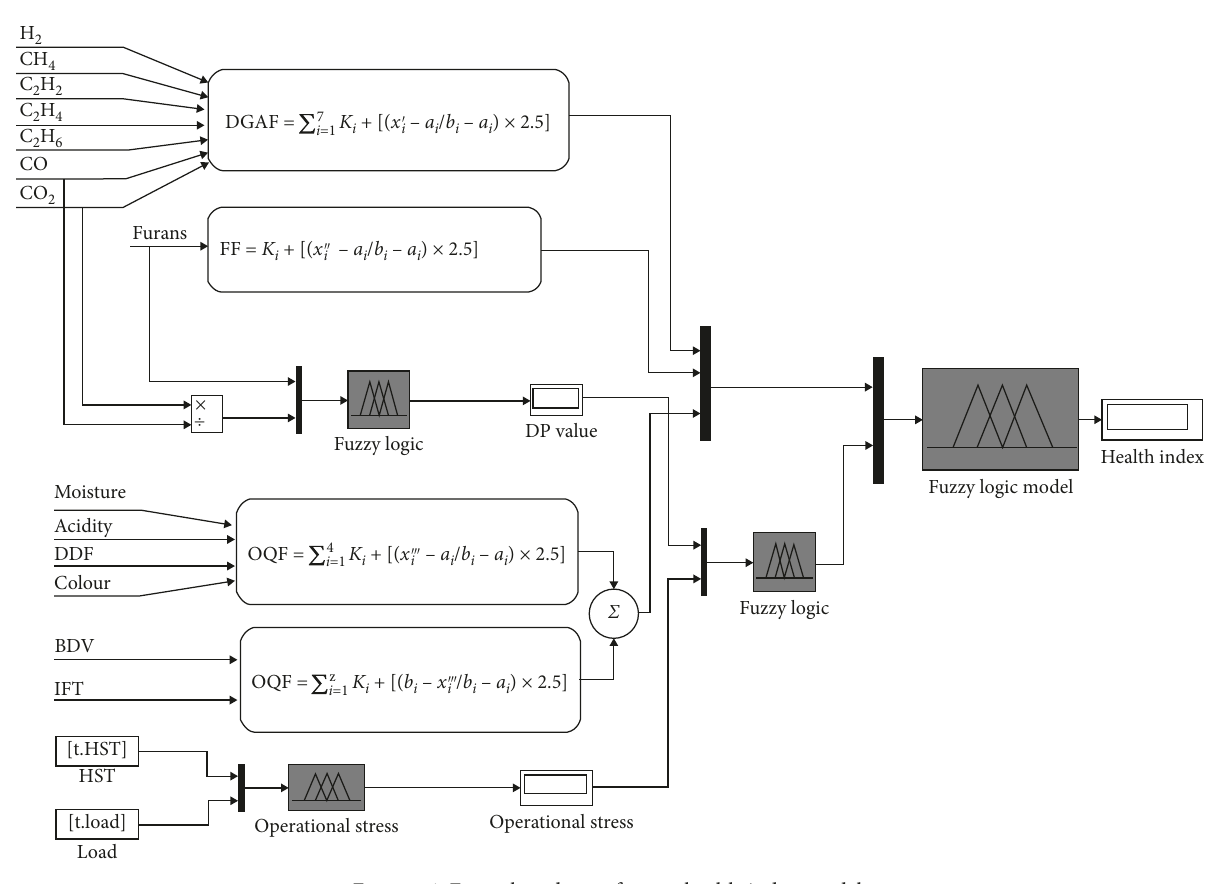
Figure 6: Fuzzy-based transformer health index model.